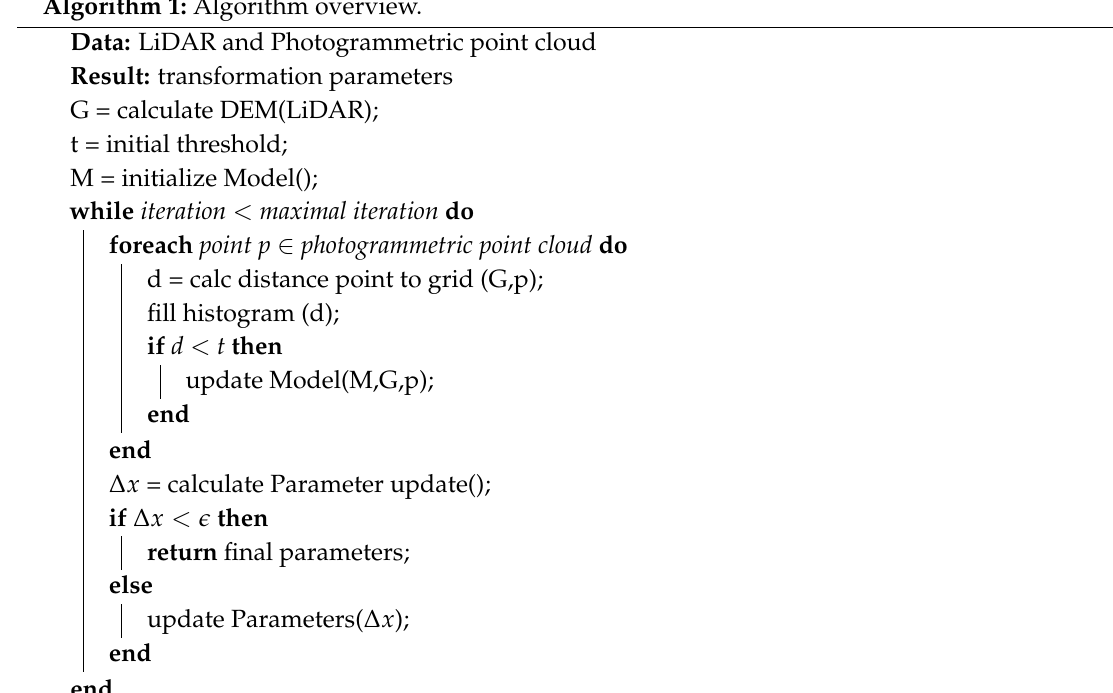
Algorithm 1: Algorithm overview. Data: LiDAR and Photogrammetric point